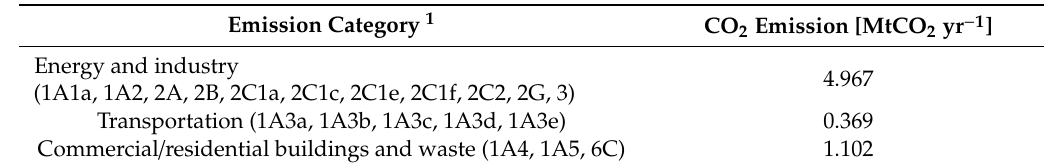
Table 3. CO 2 anthropogenic emissions inventory in Krakow as of 2010, according to 2019 edition of the Emission Database for Global Atmospheric Research (EDGAR)